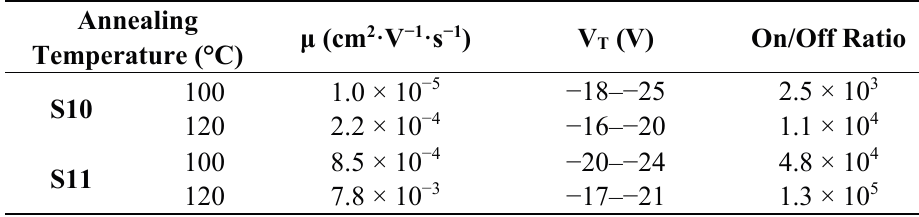
Figure 7. ( a ) Organic field effect transistor (OFETs) device geometry. Output and transfer characteristics of S10 ( b , c ) and S11 ( d , e ) based p-channel OFET annealed at 120 °C on HMDS treated n + -Si/SiO 2 substrate. The hole transfer curves were derived at drain voltages (V D ) of − 70 V. Table 1. OFET device performance of S10 and S11 thin films annealed at 100 °C, and 120 °C on HMDS treated n + -Si/SiO 2 substrates using bottom-gate, top-contact (BGTC) device